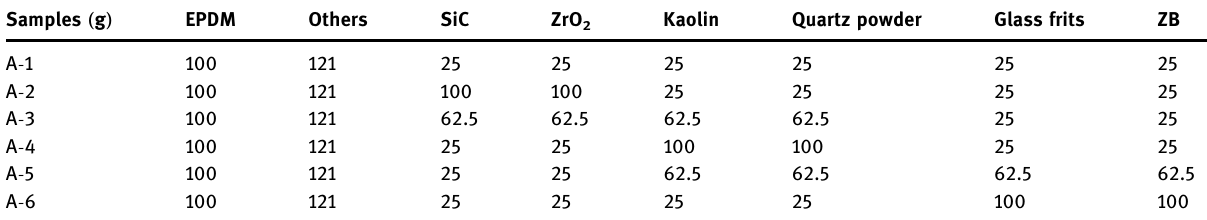
Table 1: Formulation of anti - ablation layer samples Samples ( g